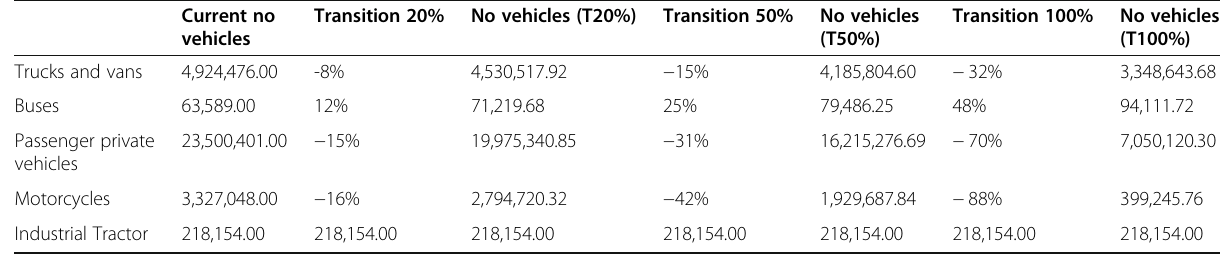
Table 1 The development of all vehicles fleet in the three different scenarios presented. The industrial tractor has not been analyzed in this study and VECs are a new vehicle model that is why there is no data